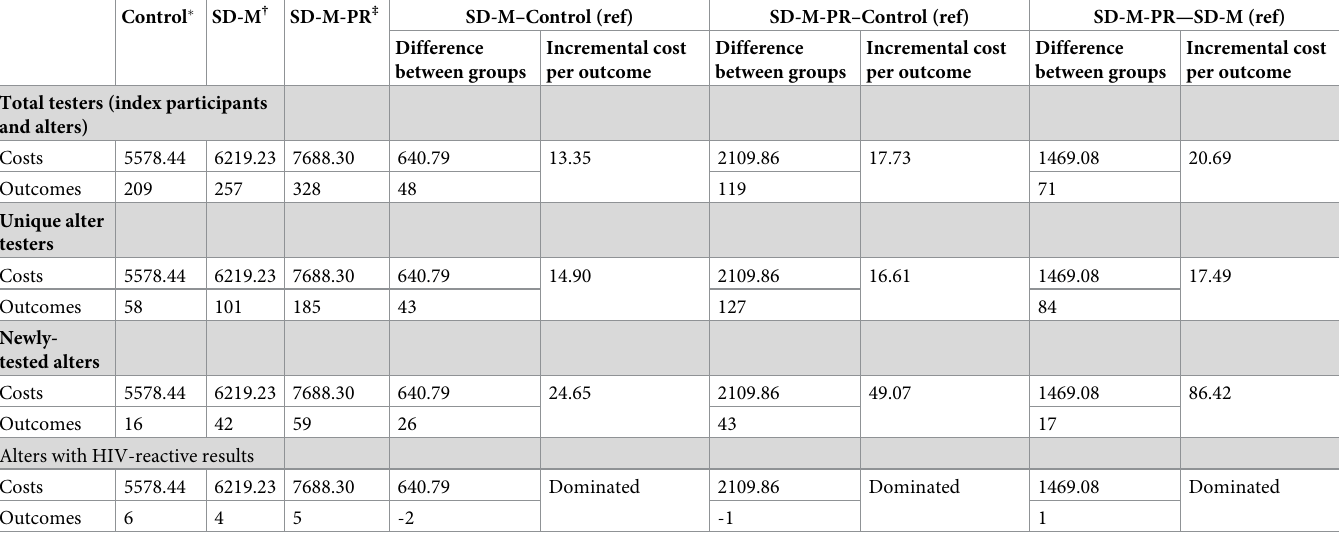
Table 4. Economic evaluation of the randomized controlled trial in China, 2019 to 2020.